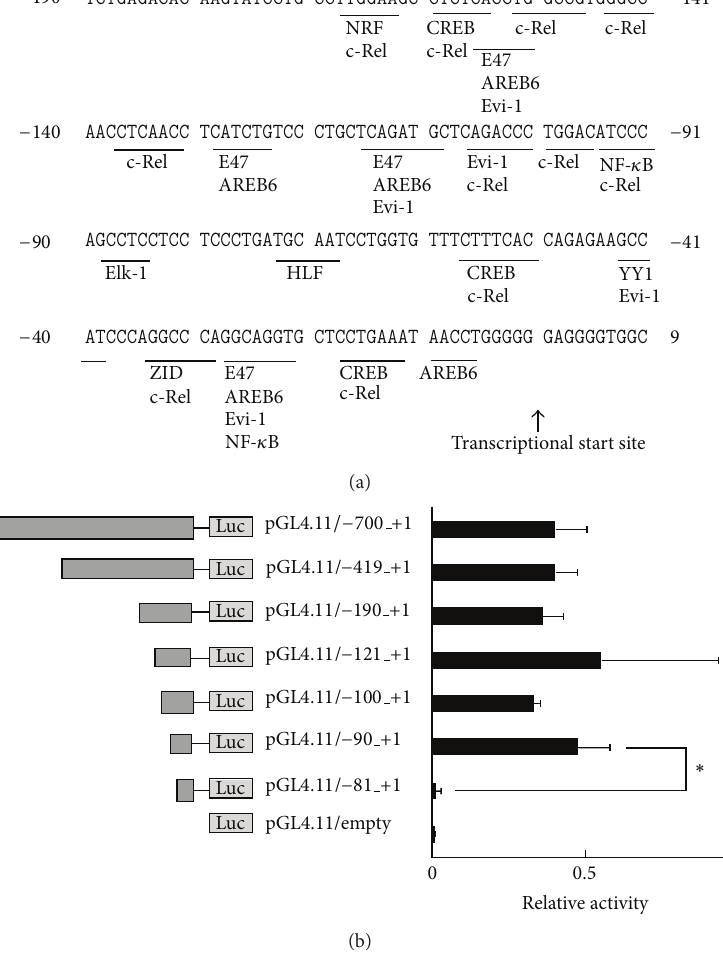
Figure 2: Nucleotide sequence of the 5 󸀠 -flanking region of the FUT1 gene and promoter activities of the FUT1 reporter gene in DLD-1 cells. (a) Consensus transcription-factor-binding motifs are detectable in the 5 󸀠 -flanking region of FUT1. Nucleotides are numbered relative to the transcription start site obtained from 5 󸀠 -RACE analysis (i.e., the observed transcription start site was set to +1). (b) FUT1 promoter deletion constructsandtheirluciferaseactivitiesinDLD-1cells.LuciferasereportedplasmidswereconstructedfromDLD-1genomicDNAbyPCRand ligation. In each case, each plasmid construct and pRL-CMV were cotransfected into DLD-1 cells and luciferase activity was determined in a dual-luciferase assay 24h aftertransfection. Firefly luciferase activities were normalized to Renilla luciferase activity to correct for differences intransfectionefficiency.Theresultsobtainedinthreeindependentexperimentsareexpressedasmean ± SD.Significantdifferences( 𝑃 < 0.05 ) are indicated by